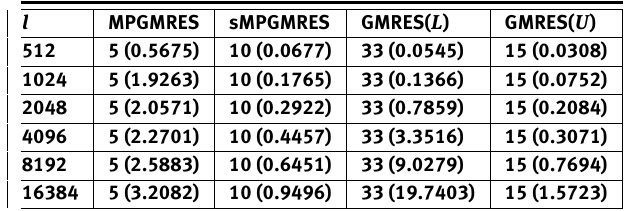
Table 4. The number of iterations and computing time in seconds (in brackets) for Example 4.2, when L and U are used as